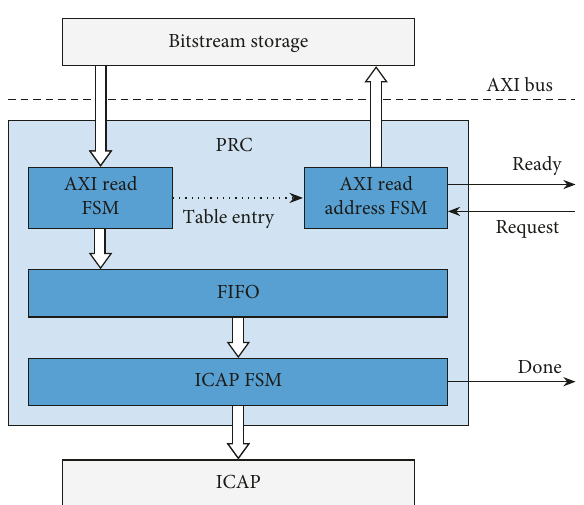
Figure 7: Block diagram of the custom PRC and its interfaces (excluding clock/reset).